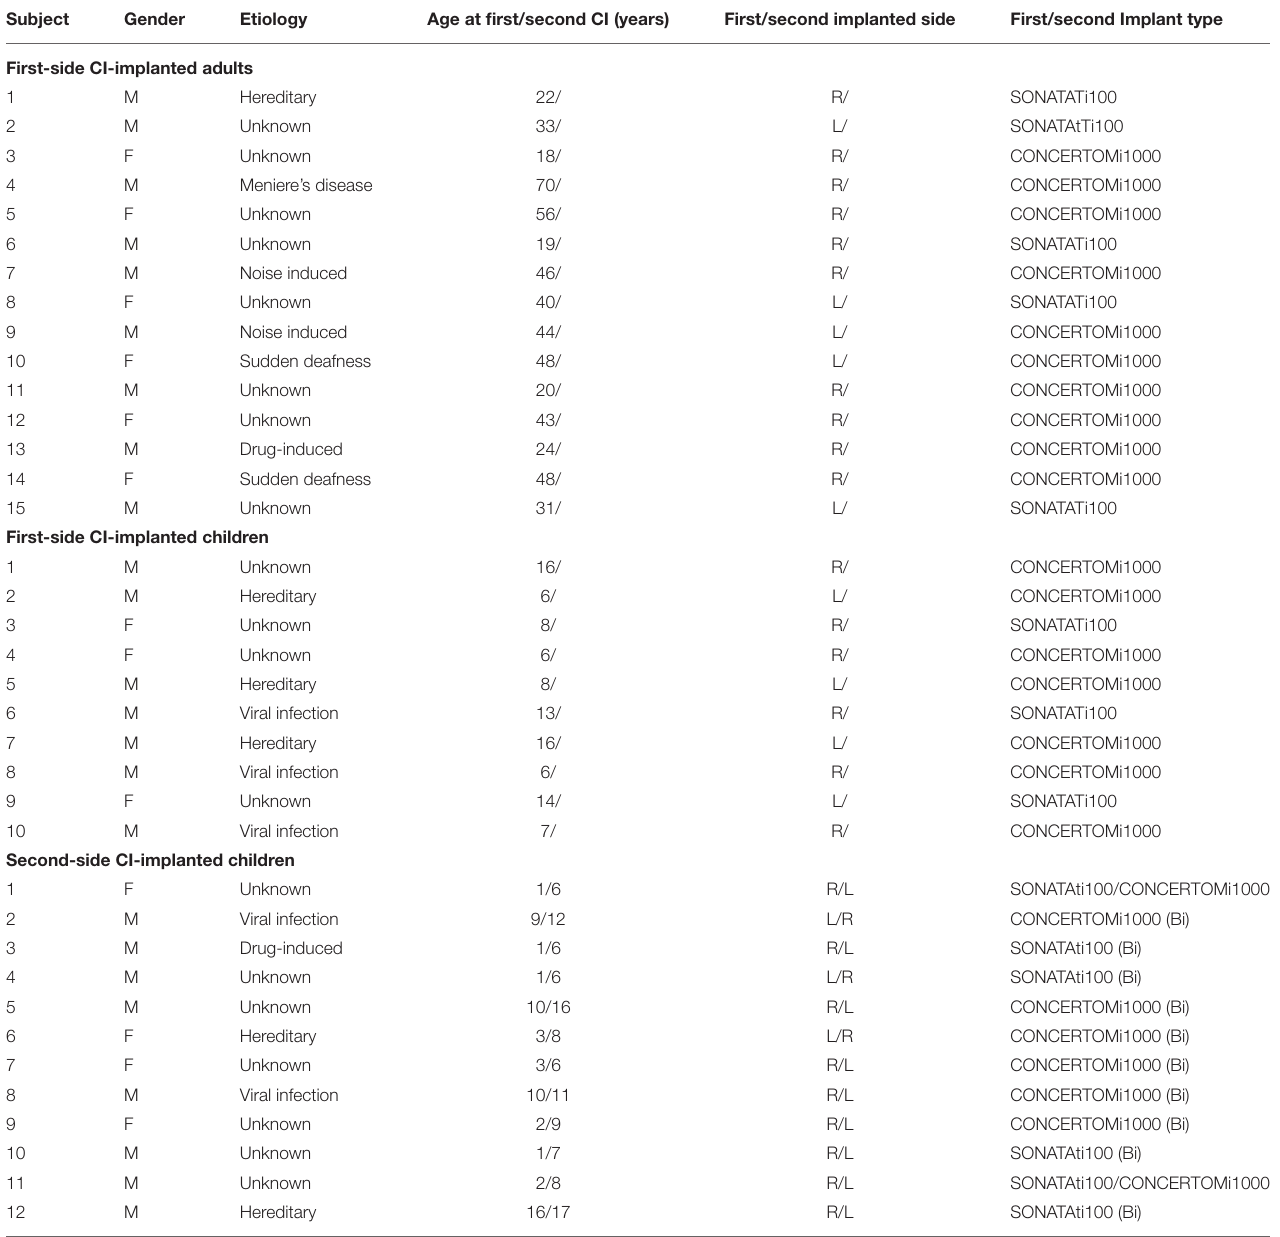
TABLE 1 | The demographic information of participants with cochlear